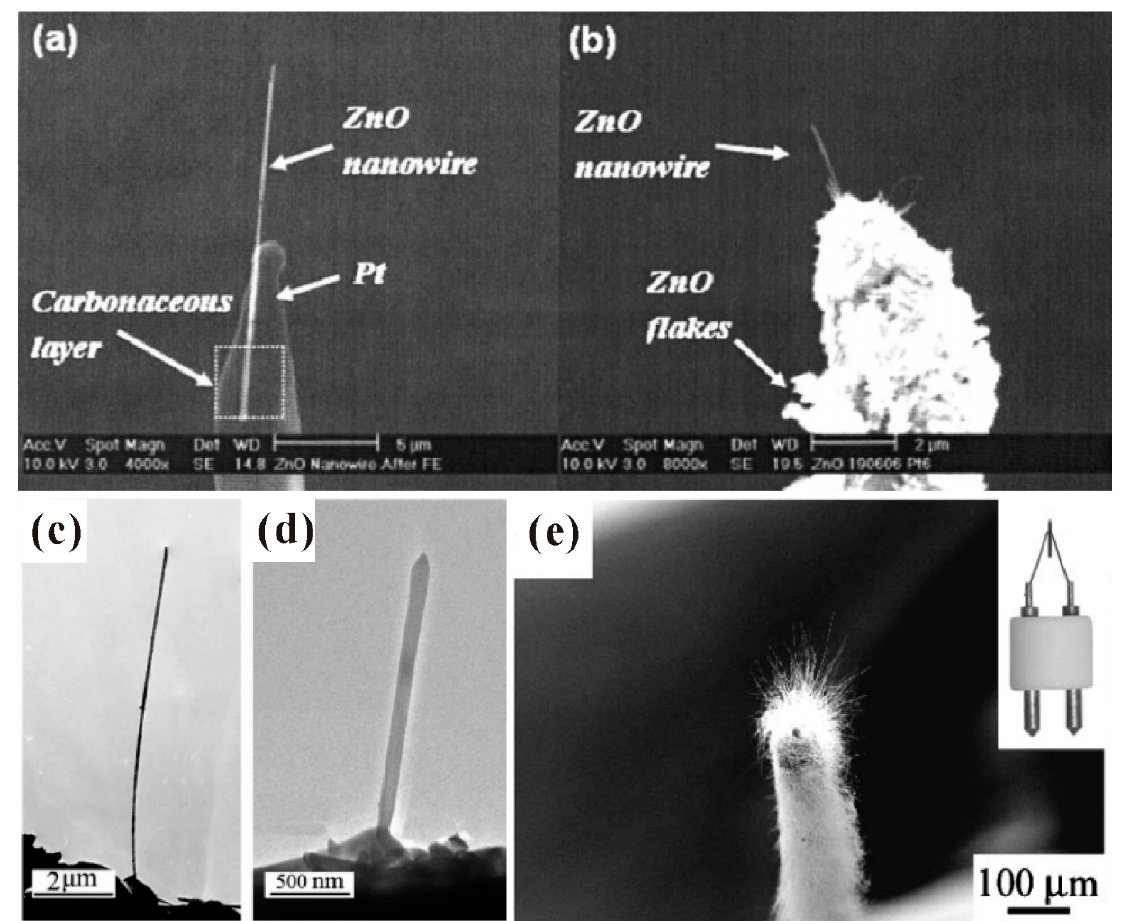
Figure 9. Single ZnO nanowire fabricated on platinum ( a , b ) and tungsten ( c – e ) probes. In ( a , c , d ), the nanowires were attached on the probe. While in ( b , e ), the nanowires were grown on the probe. ( a , b ) Reproduced from [62], with the permission of AIP Publishing, 2008. ( c , d ) Reproduced from [63], with the permission of ACS Publications, 2007. ( e ) Reproduced from [64], with the permission of AIP Publishing, 2003.